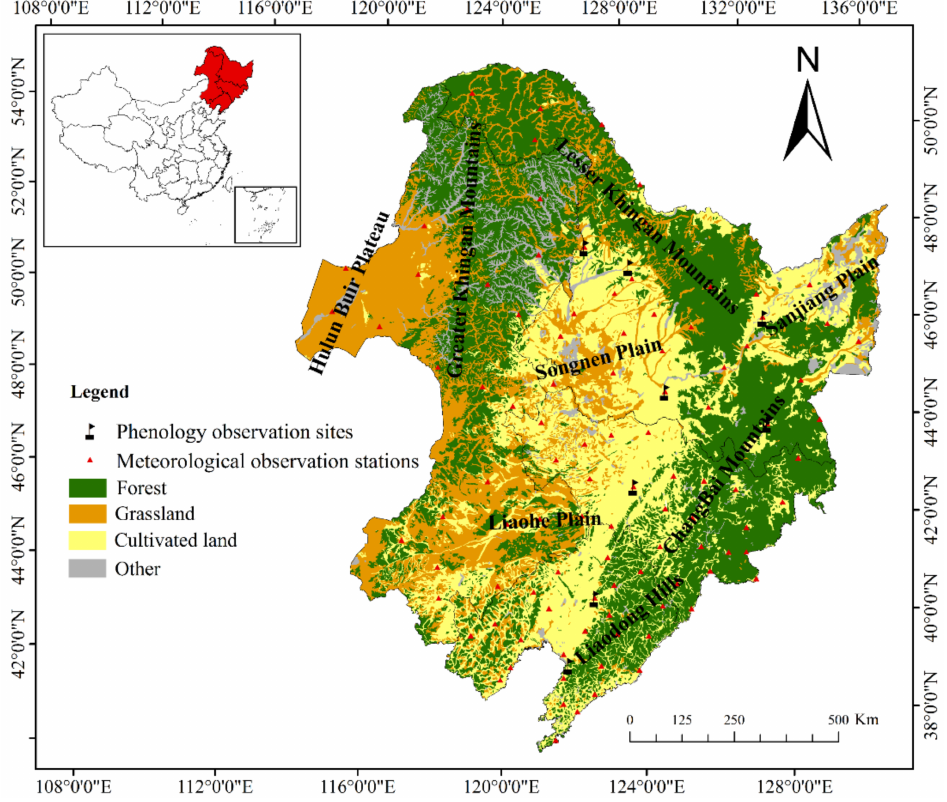
Figure 2. Vegetation types in northeast China and locations of the eight phenological observation